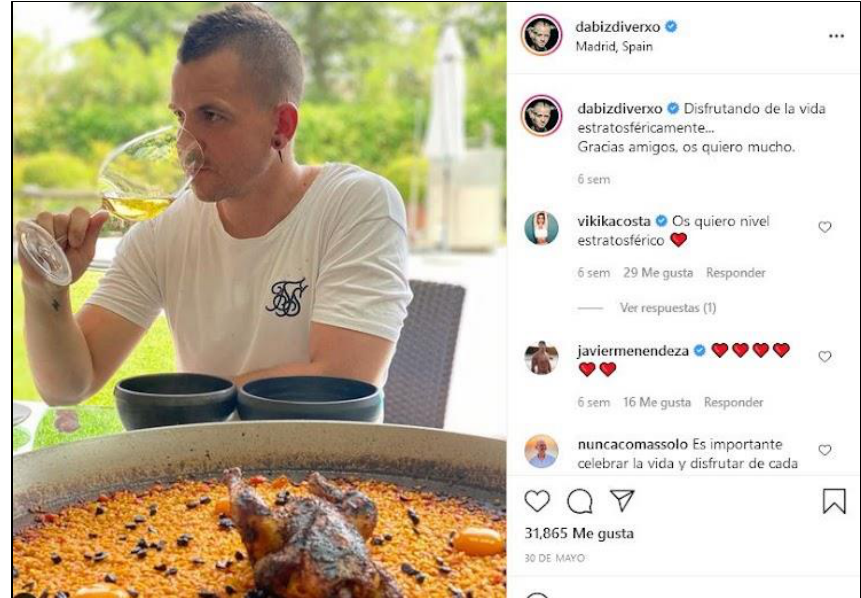
Figure A2. Image of the Instagram of the chef Dabiz Figure 2. Image of the Instagram of the chef Dabiz Muñoz.